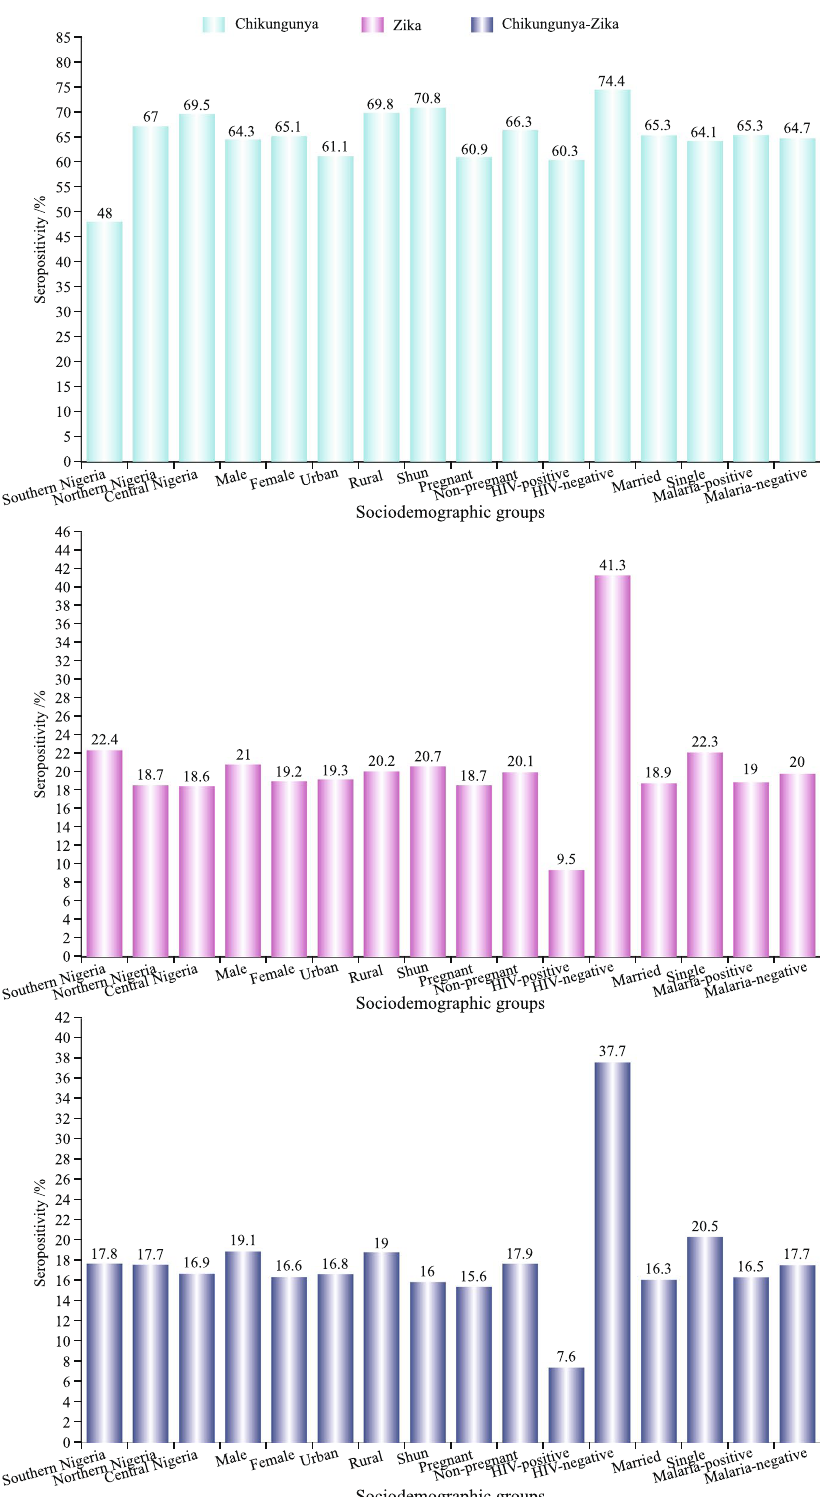
Fig. 2 Sociodemographic characteristics and antibody seropisitivity of CHIKV, ZIKV and CHIKV-ZIKV